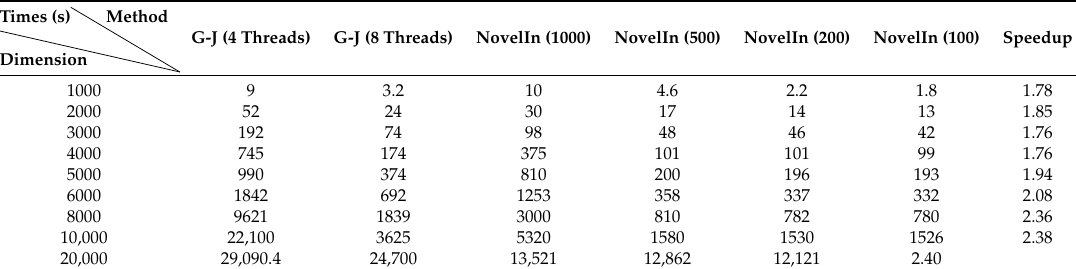
Table 2. The results on GF ( 2 8 ) .